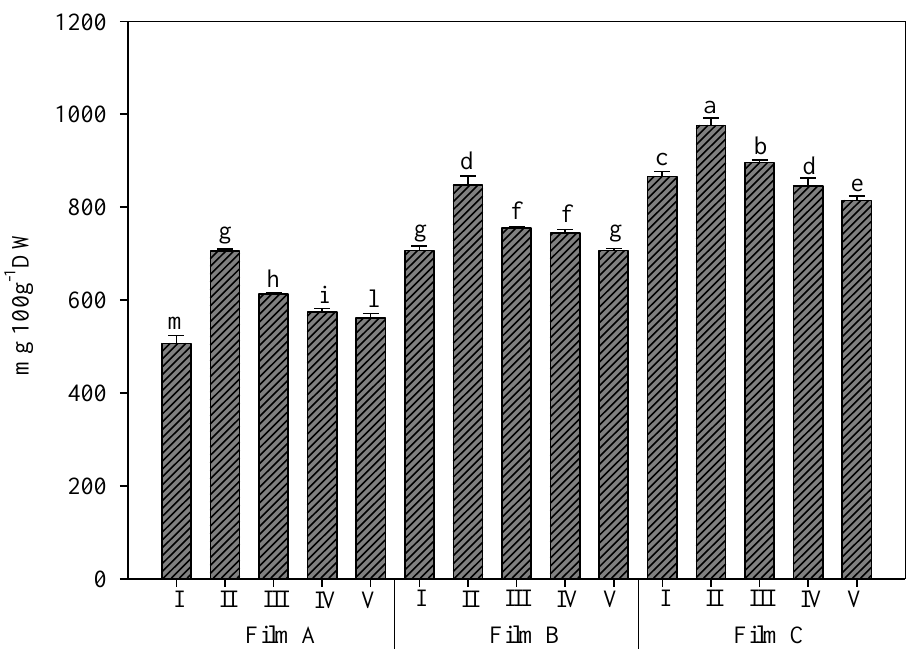
Figure 2. Chlorophyll a content (mg/100 g of dry weight D.W.) in wild rocket leaves as affected by interaction between greenhouse cover film (Film A: diffused light film; Film B: clear film; Film C: diffused light film with UV-B window) and UV-B applications (I: not treated with UV-B; II: treated with UV-B for 45 s; III: treated with UV-B for 150 s; IV: treated with UV-B for 330 s; V: treated with UV-B for 660 s). Vertical bars indicate standard error; different letters indicate significant differences according to Tukey’s test ( p ≤ 0.05).